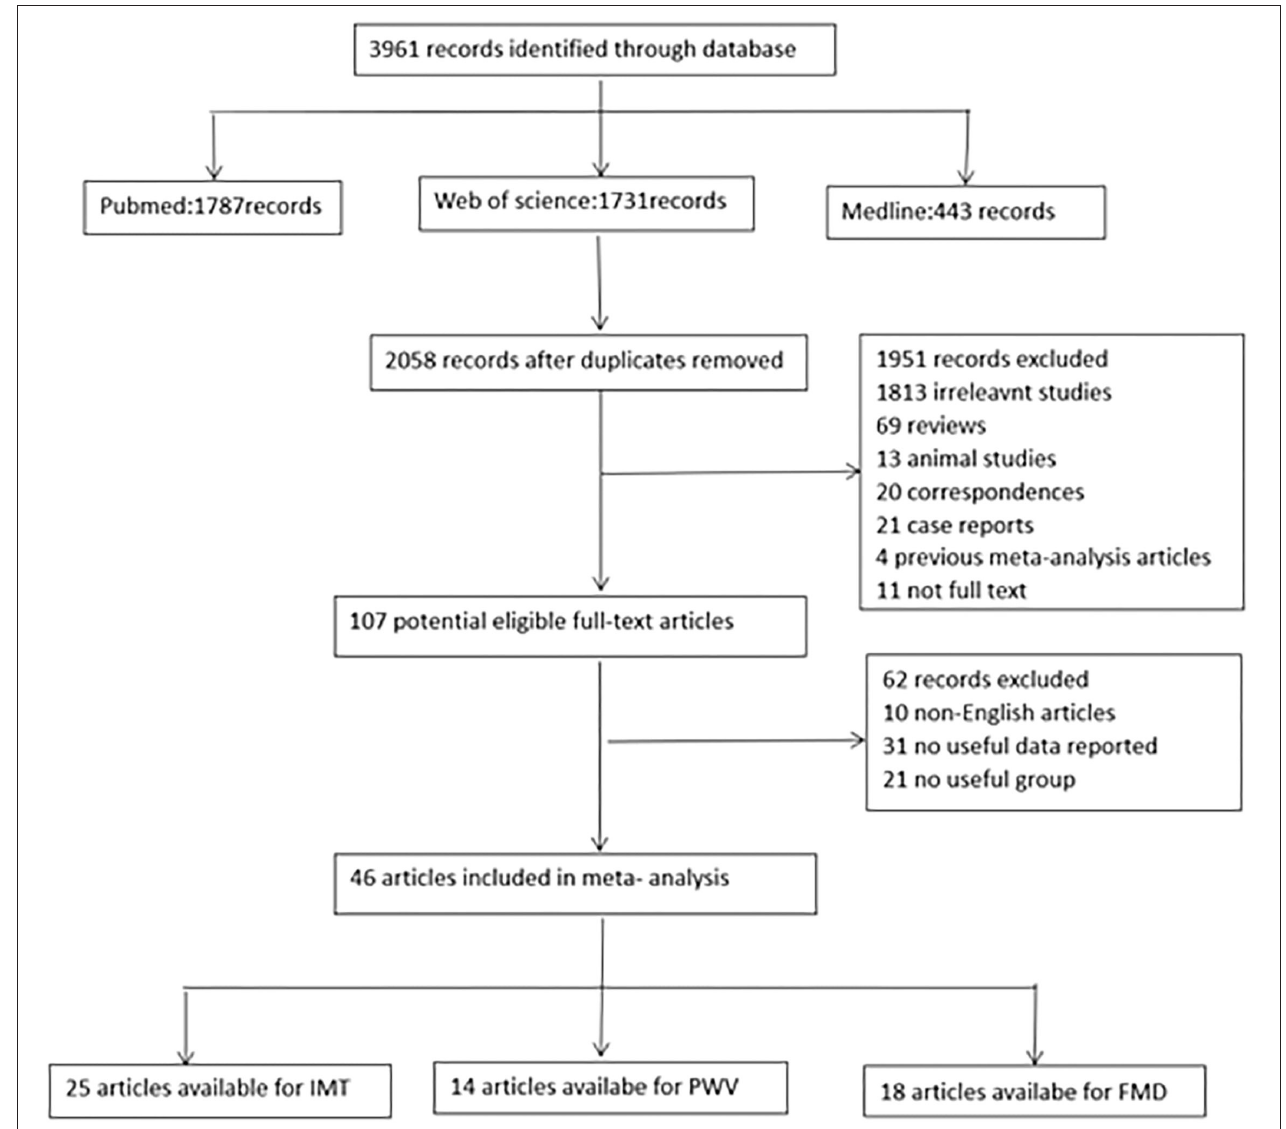
FIGURE 1 | Flow chart for identification of studies. FMD indicates flow-mediated vasodilation; IMT, intima media thickness; PWV, pulse wave